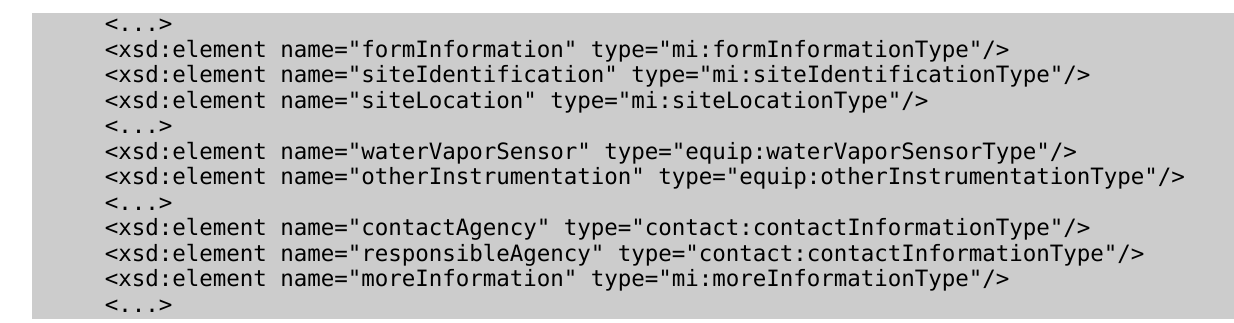
Fig 1. Excerpt from the XML Data Schemas